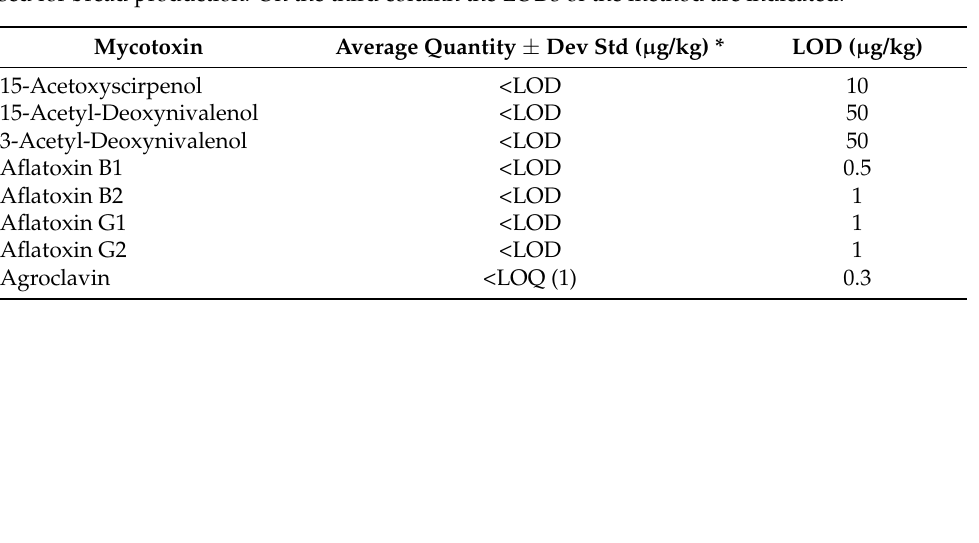
Figure 6. Bread and slices of bread prepared from wheat flour ( A ) and rye-wheat blend (30:70) ( B ).